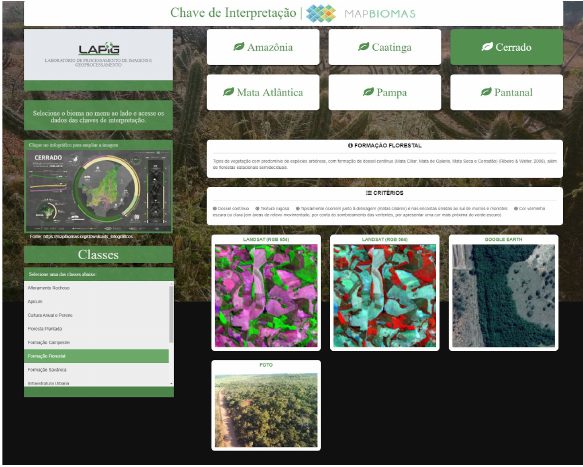
Figure 3. Interpretation key of Brazilian biomes.